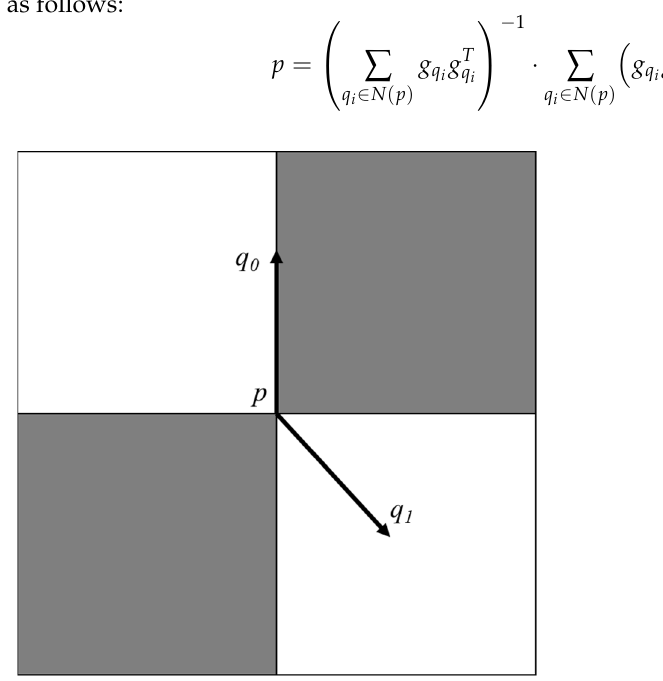
Figure 4. Gray-gradient image at corner.